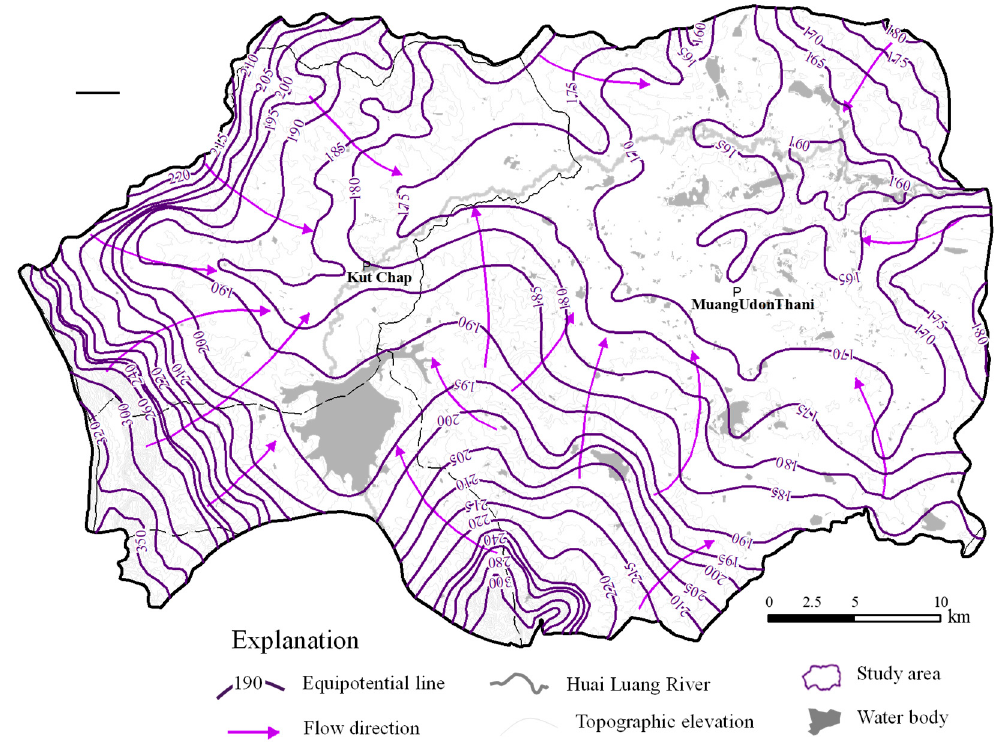
Figure 5. Regional groundwater flow of the CHLB.